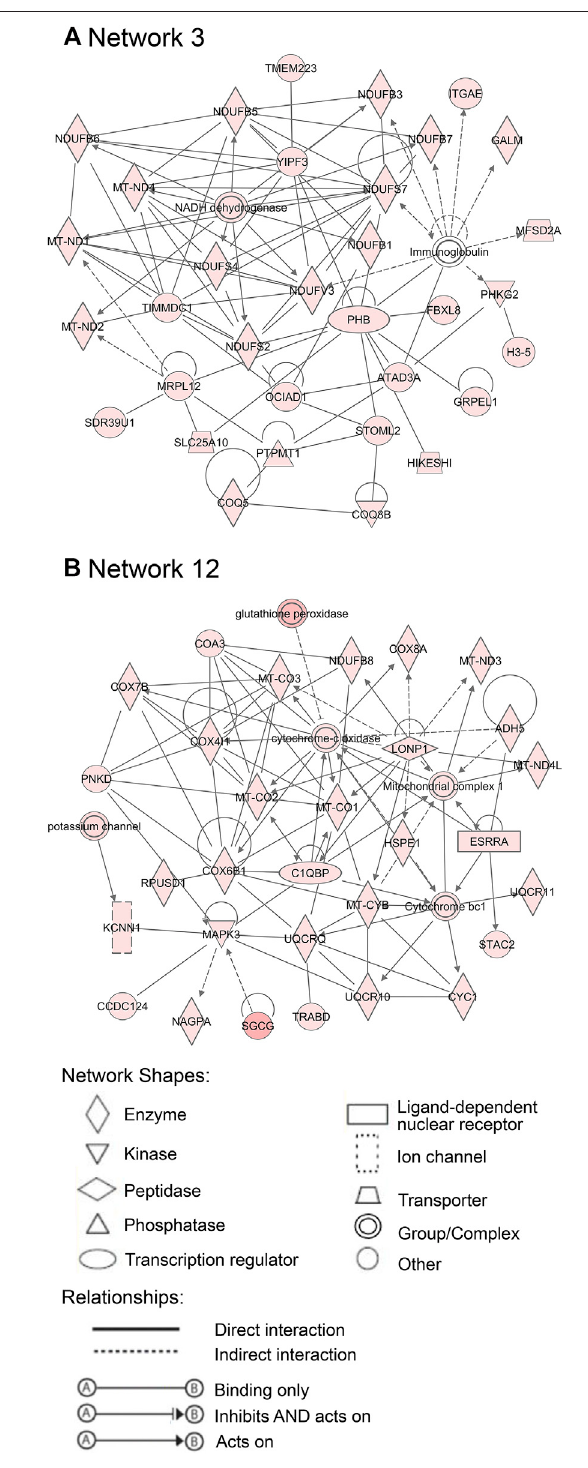
FIGURE7| Importantnetworksconnectedwithcluster1.Network3 (A) and network 12 (B) are associated with mitochondrial functions. Red color of molecules represents downregulation in the second half of gestation and the intensity of each color shows the strength of regulation.